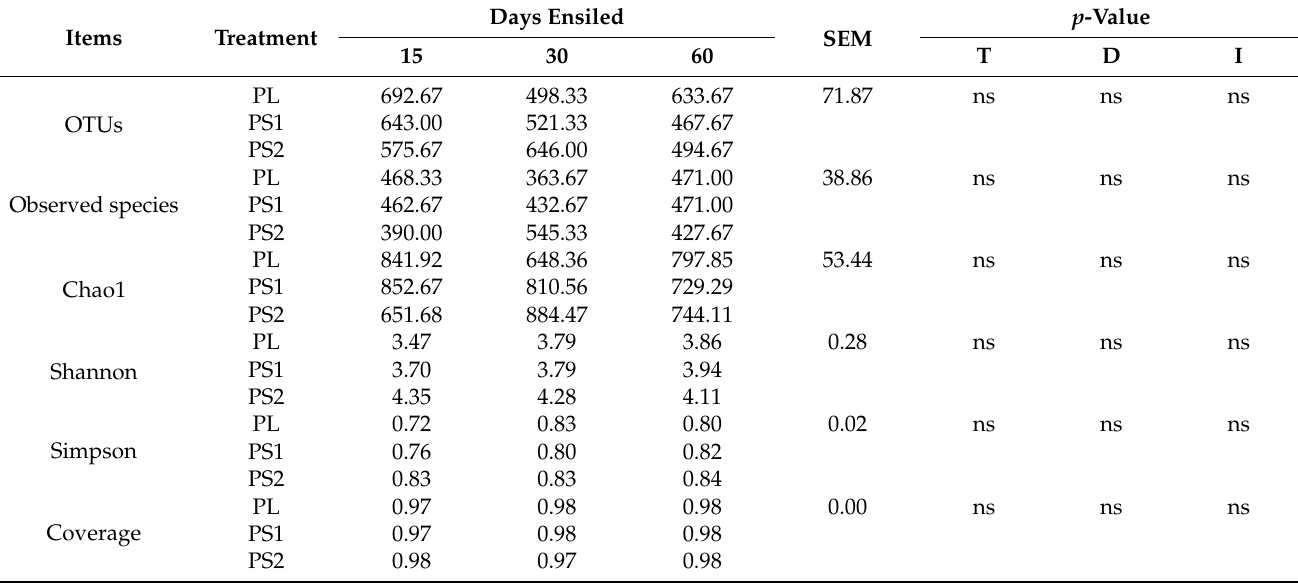
Table 4. Alpha diversity of the bacterial communities of the kudzu silage.